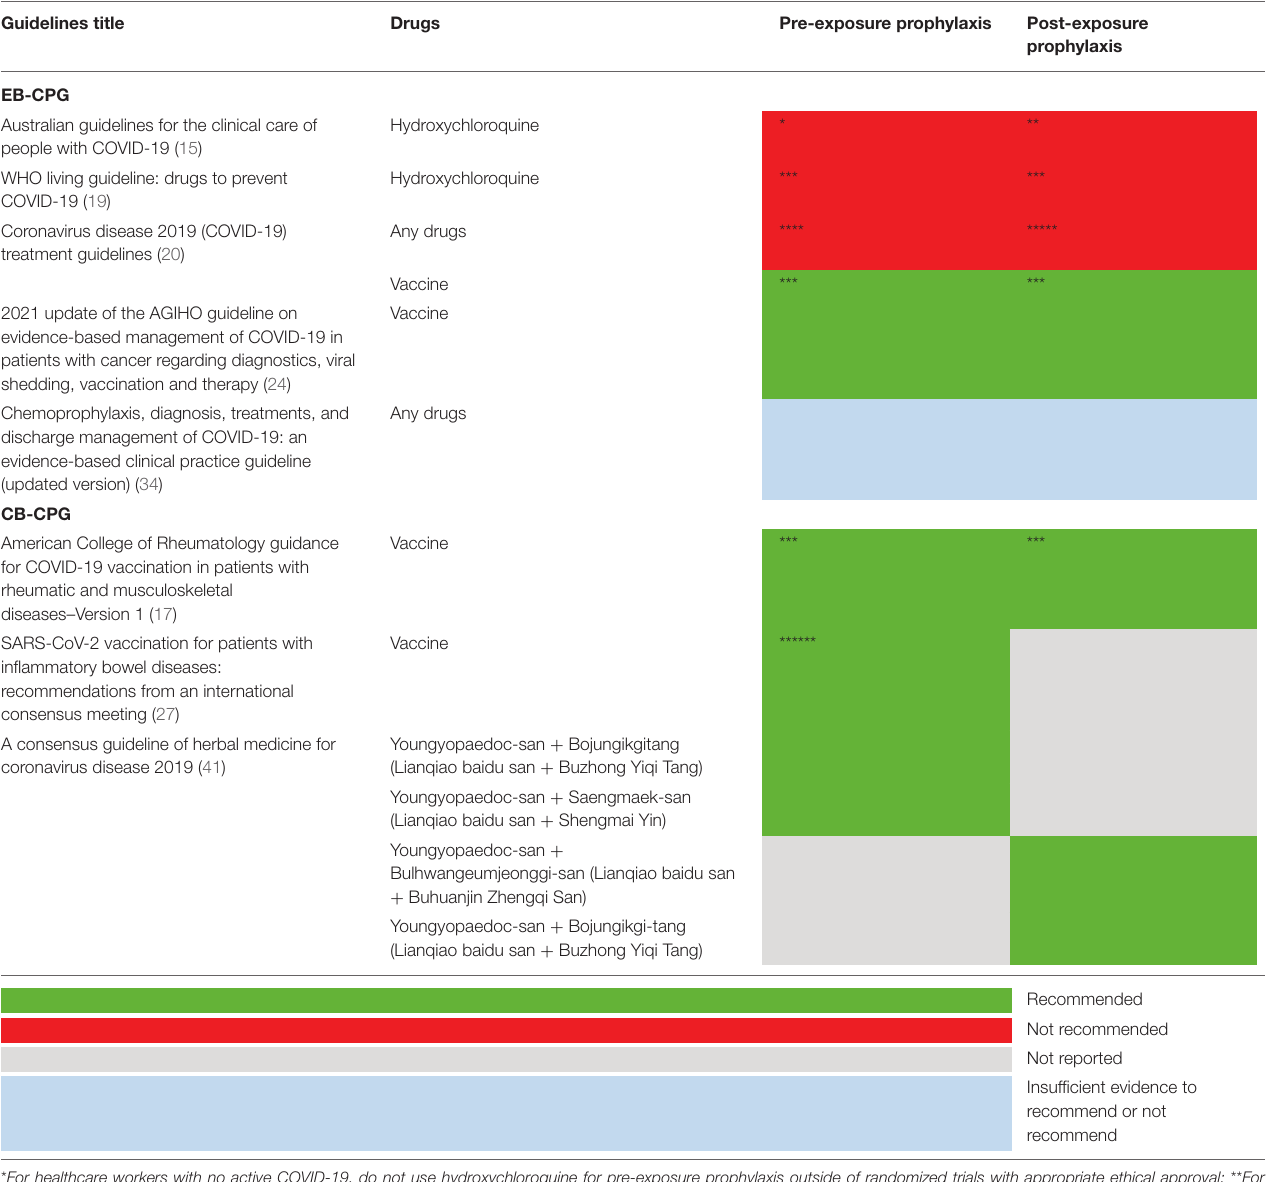
TABLE 2 | Recommendations on chemoprophylaxis of COVID-19. Drugs Pre-exposure